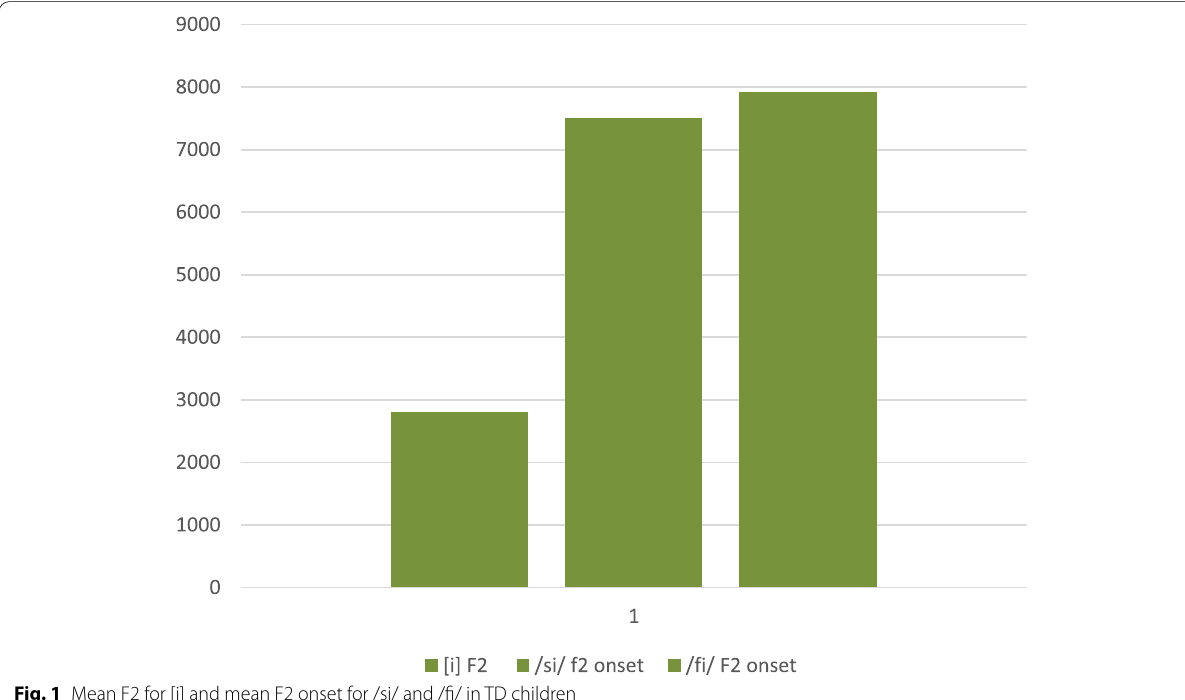
Fig. 1 Mean F2 for [i] and mean F2 onset for /si/ and /fi/ in TD